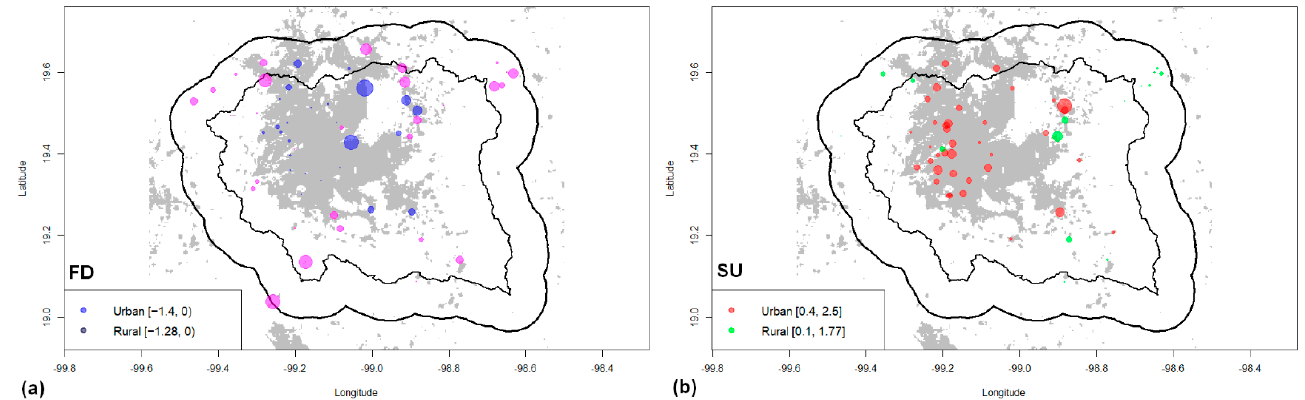
Figure 5. Geographic distribution in the VMB of the trends in ( a ) FD (days/year) and ( b ) SU (days/year) for statistically significant urban and rural climate stations. The urban area is marked in gray. The legends of the points indicate the maximum and minimum significant values of the trends found for each category of station. The size of the circles indicates the magnitude of the trend and is on the same scale in both categories. The red color points are for urban stations with a positive trend; the green color points are for rural stations with a positive trend; the blue color points are for urban stations with a negative trend; and the pink color points are for rural stations with a negative trend.